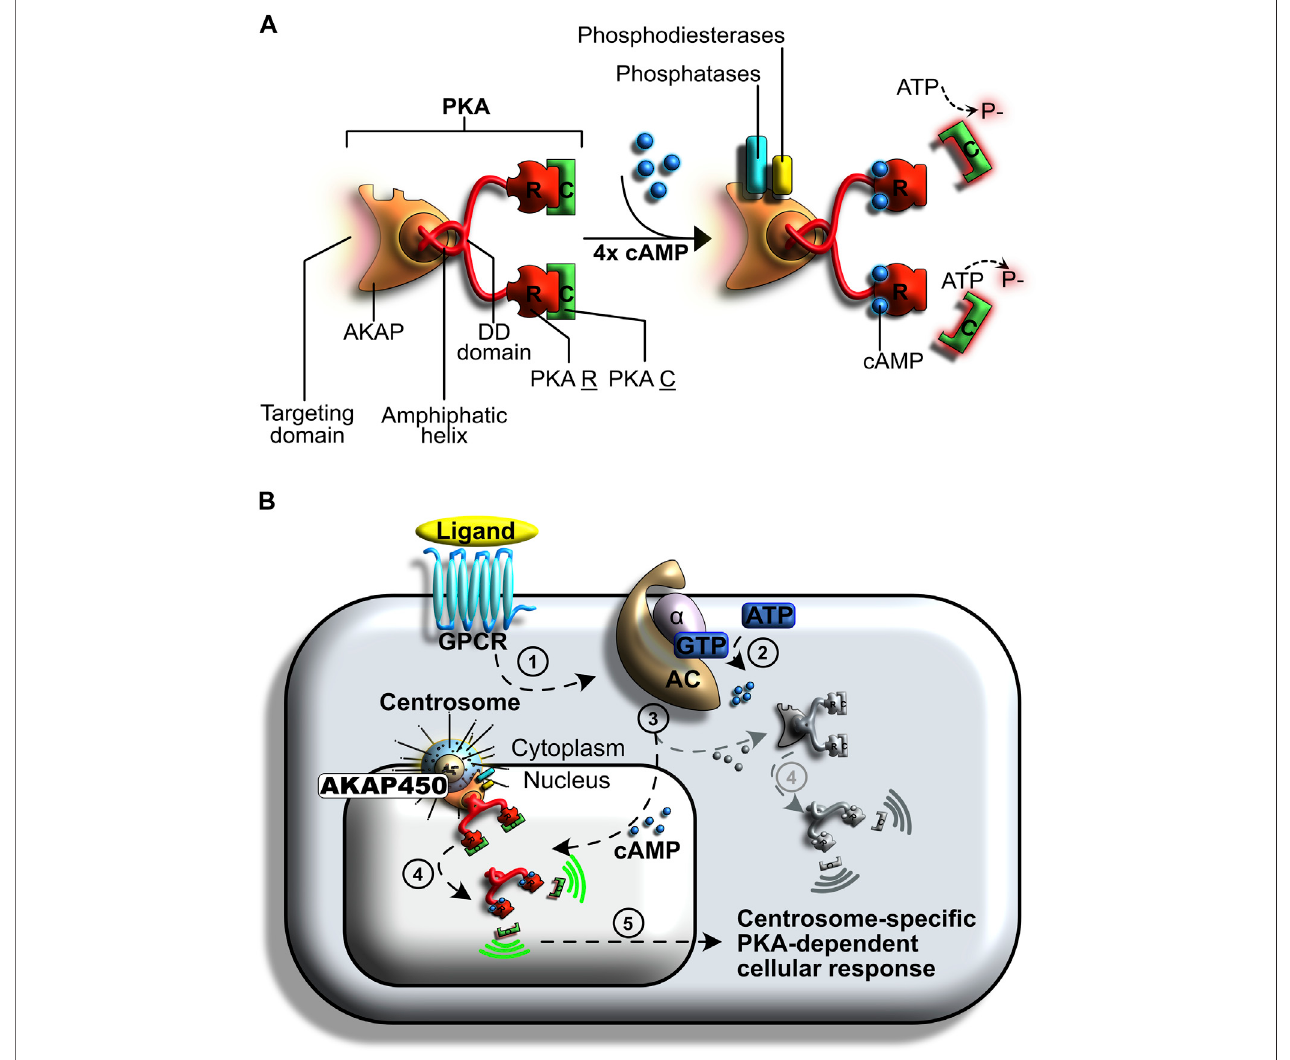
FIGURE5| Centrosome-speci fi cregulationofprotein kinase A(PKA) signaling. (A) PKAisatetrameric holoenzymecomposed oftwo regulatory subunits and two catalytic subunits. Its activity relies on cyclic AMP (cAMP) cellular levels and is involved in many regulatory processes. (B) Regulation of PKA following G protein-coupled receptor (GPCR) activation. A ligand binds to the GPCR (step 1), initiating the signal transduction cascade. This signal induces a GDP to GTP exchange on a heterotrimeric G complex (step 2). The G α subunit is released and binds to adenylyl cyclase (AC), an event that induces the formation of cyclic adenosine monophosphate (cAMP) from ATP. A subpopulation of PKA anchors at the centrosomes (step 3). The resulting AKAP450 complex increases PKA af fi nity for cAMP. CentrosomalPKAisselectivelyactivatedbycAMP,whilstcytosolicPKA(showningrey)remainsmostlyinactive(step4).Aspecializedcellularresponseisinducedbythe catalytic activation of PKA at centrosomes (step